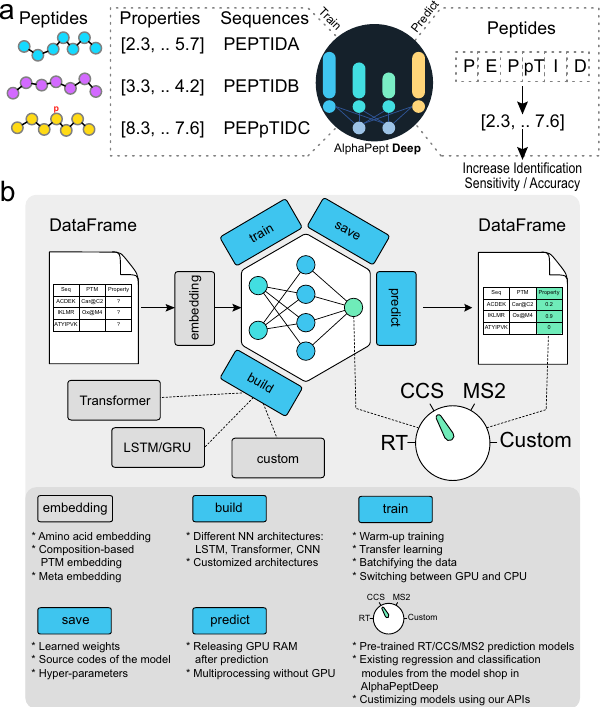
Fig. 1 | Overview of the AlphaPeptDeep framework. a Measured peptide prop- erties are encoded with the respective amino acid sequences and used to train a network in AlphaPeptDeep (left). Once a model is trained, it can be used on arbi- trary sets of peptide sequences to predict the property of interest. This can then improve the sensitivity and accuracy of peptide identi fi cation. b The Alpha- PeptDeep framework reads and embeds the peptide sequences of interest. Its components include the build functionality in which the model can build. Meta embedding referstotheembeddingof metainformationsuchasprecursorcharge states, collisional energies, instrument types, and other non-sequential inputs. It is thentrained,savedandusedtopredictthepropertyofinterest.Thedialrepresents the different standard properties that can be predicted (RT retention time, CCS collision cross section, MS2 intensities of fragment spectra). Custom refers to any otherpeptidepropertyofinterest.Thelowerpartlistsaspectsofthefunctionalities in more detail. NN neural network, LSTM long short-term memory, CNN convolu- tional neural network, GRU gated recurrent unit, API application programming interface, PTM post-translational modi fi